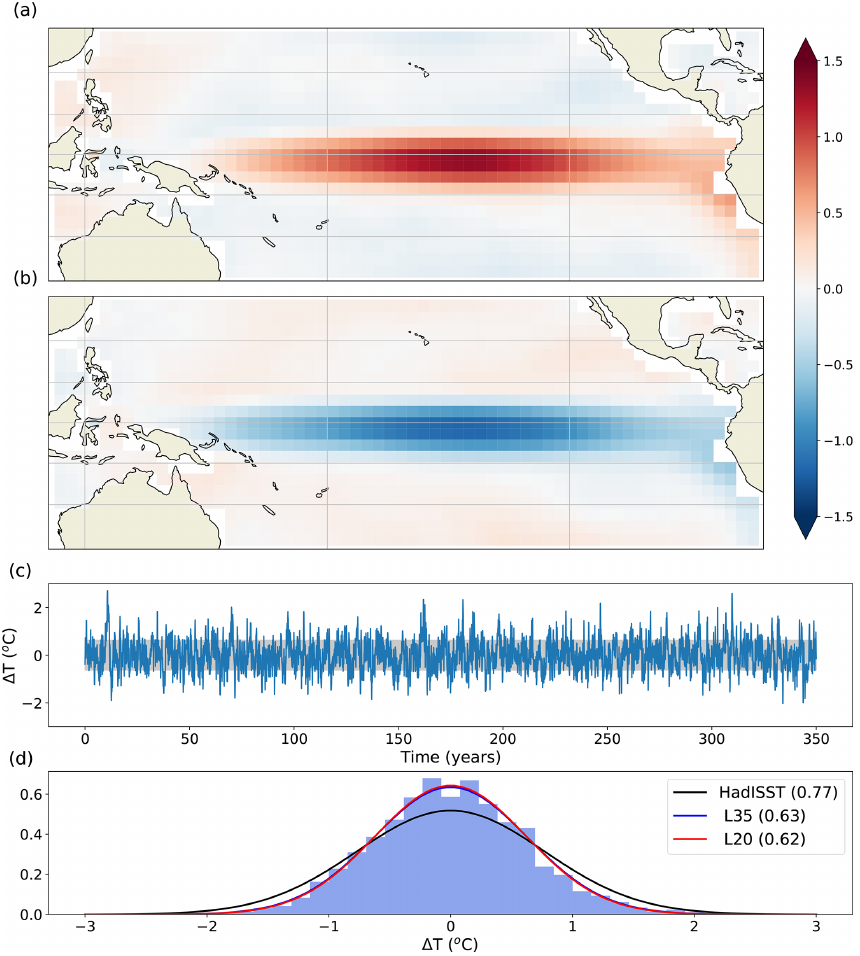
Figure 13. Composite anomaly of (a) El Niño events and (b) La Niña events from the L35 simulation. El Niño–Southern Oscillation (ENSO) events are defined as those which exceed ± 1 standard deviation anomaly within the Niño 3.4 region. (c) SST anomaly time series and (d) histogram of SST anomaly distribution relative to the mean for the years 1601–1950 from the L35 simulation. The Gaussian curves in panel (d) are fits to the distribution of Niño 3.4 SST anomalies for HadISST (black, Trenberth (2020)), L35 (blue) and L20 (red). The blue and red lines are very close and the red line mostly overlies the blue line. Standard deviations are given in